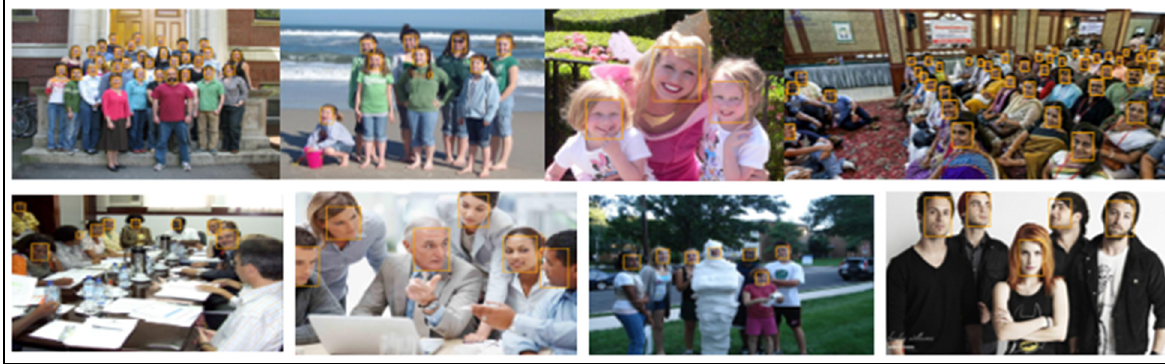
Figure 6. Pose images results (WIDER FACE dataset).